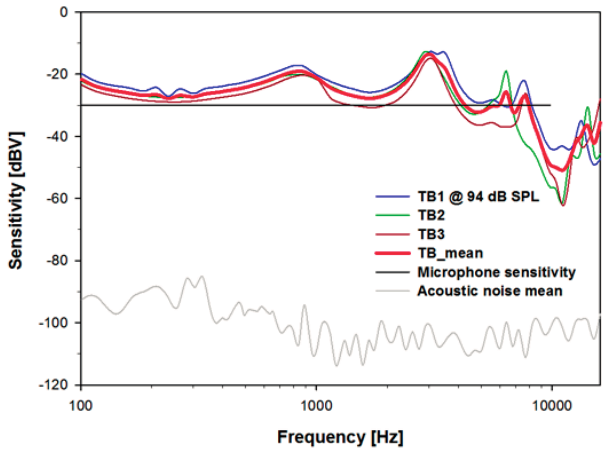
Figure 7. Voltage sensitivity of the in situ trans-tympanic microphone with 94 dB SPL sound pressure at the entrance of the ear canal for TB1–3 and their mean. The average noise floor is typically 60–70 dB